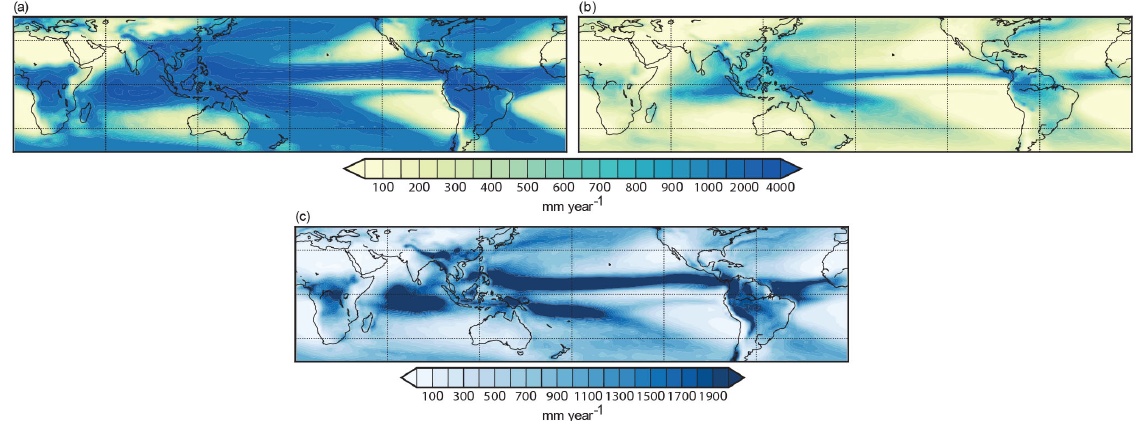
Figure 5. The mean (2000–2009) annual total precipitation of (a) the ACCESS-UKCA climatology (b) the satellite climatology from TRMM (Huffman et al., 2007) and (c) the difference between ACCESS-UKCA and the TRMM product (model – observations). Units are in mmyr − 1 .